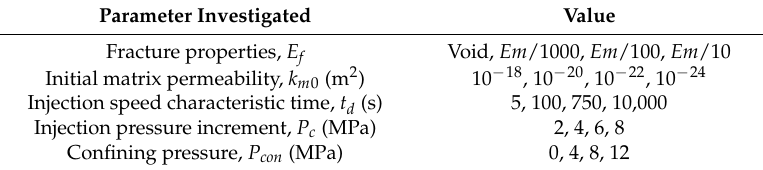
Table 3. Simulations for the investigation of dynamic fracture–matrix